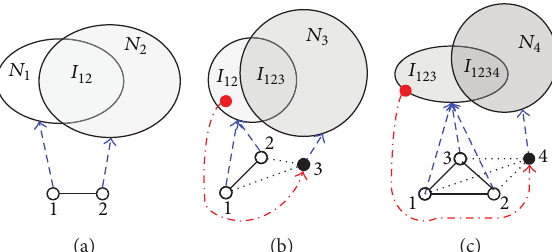
Figure 2: An illustration of mining cliques based on predicted protein pairs. (a) Components of intersection 𝐼 12 between the neighbors of node 1 and node 2 are candidates to form 3 cliques. (b) Node 3 derived from 𝐼 12 with nodes 1 and 2 forms 3 cliques. The neighbors of node 3 intersect 𝐼 12 and construct the candidate set 𝐼 123 of 4 cliques. (c) The node in the 𝐼 123 composes of nodes 1, 2, and 3 to form 4 cliques. The neighbors of node 4 derived from 𝐼 123 intersect 𝐼 123 and construct the candidate set 𝐼 1234 for forming 5 cliques. This procedure is repeated until the maximum clique is found based on node 1 and node 2.